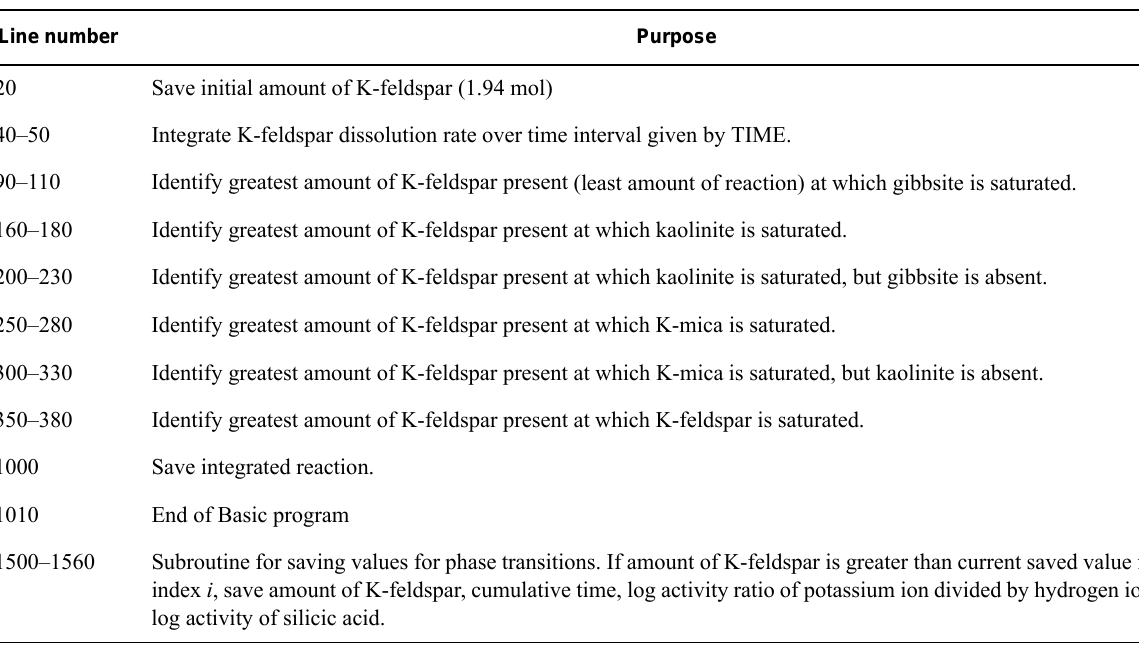
Table 23. Description of Basic program for K-feldspar dissolution kinetics and identification of phase transitions.